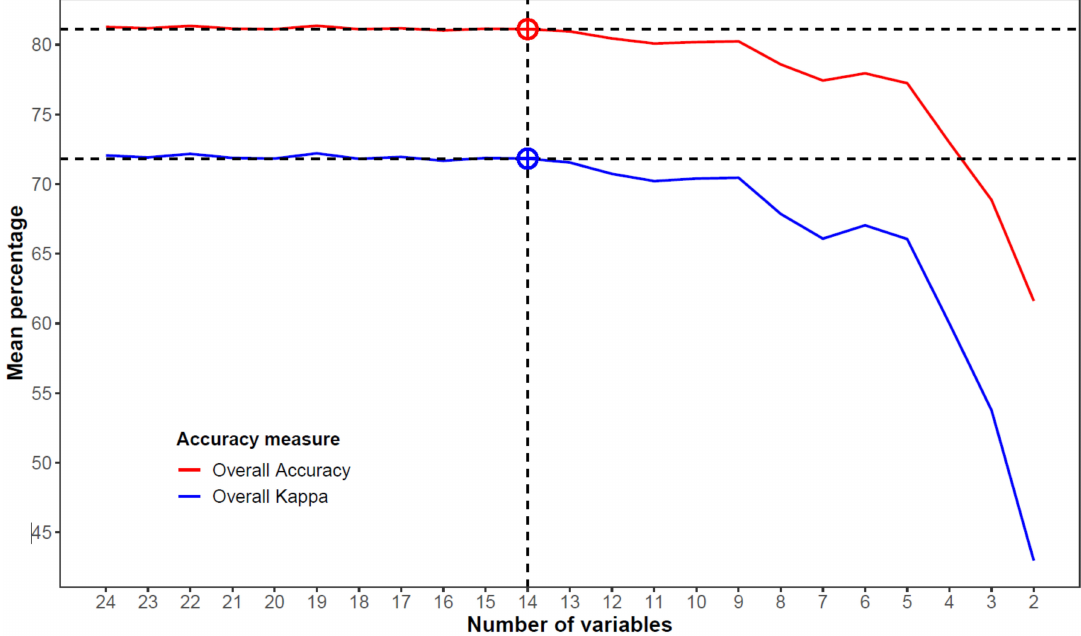
Figure 2. Variation in mean Overall Accuracy and mean Kappa Coefficient along the stepwise backward variable selection procedure. In each step, 25 random forests were computed, and an independent validation was performed for each. The red circle and dashed line mark the threshold point selected as the best variable set (14 predictors) to perform the supervised classification.